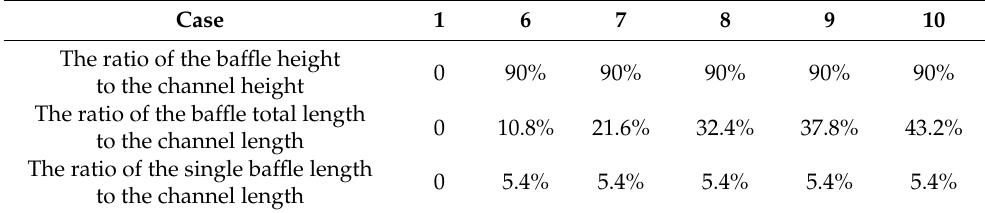
Table 6. Cases under different total dimensionless lengths of